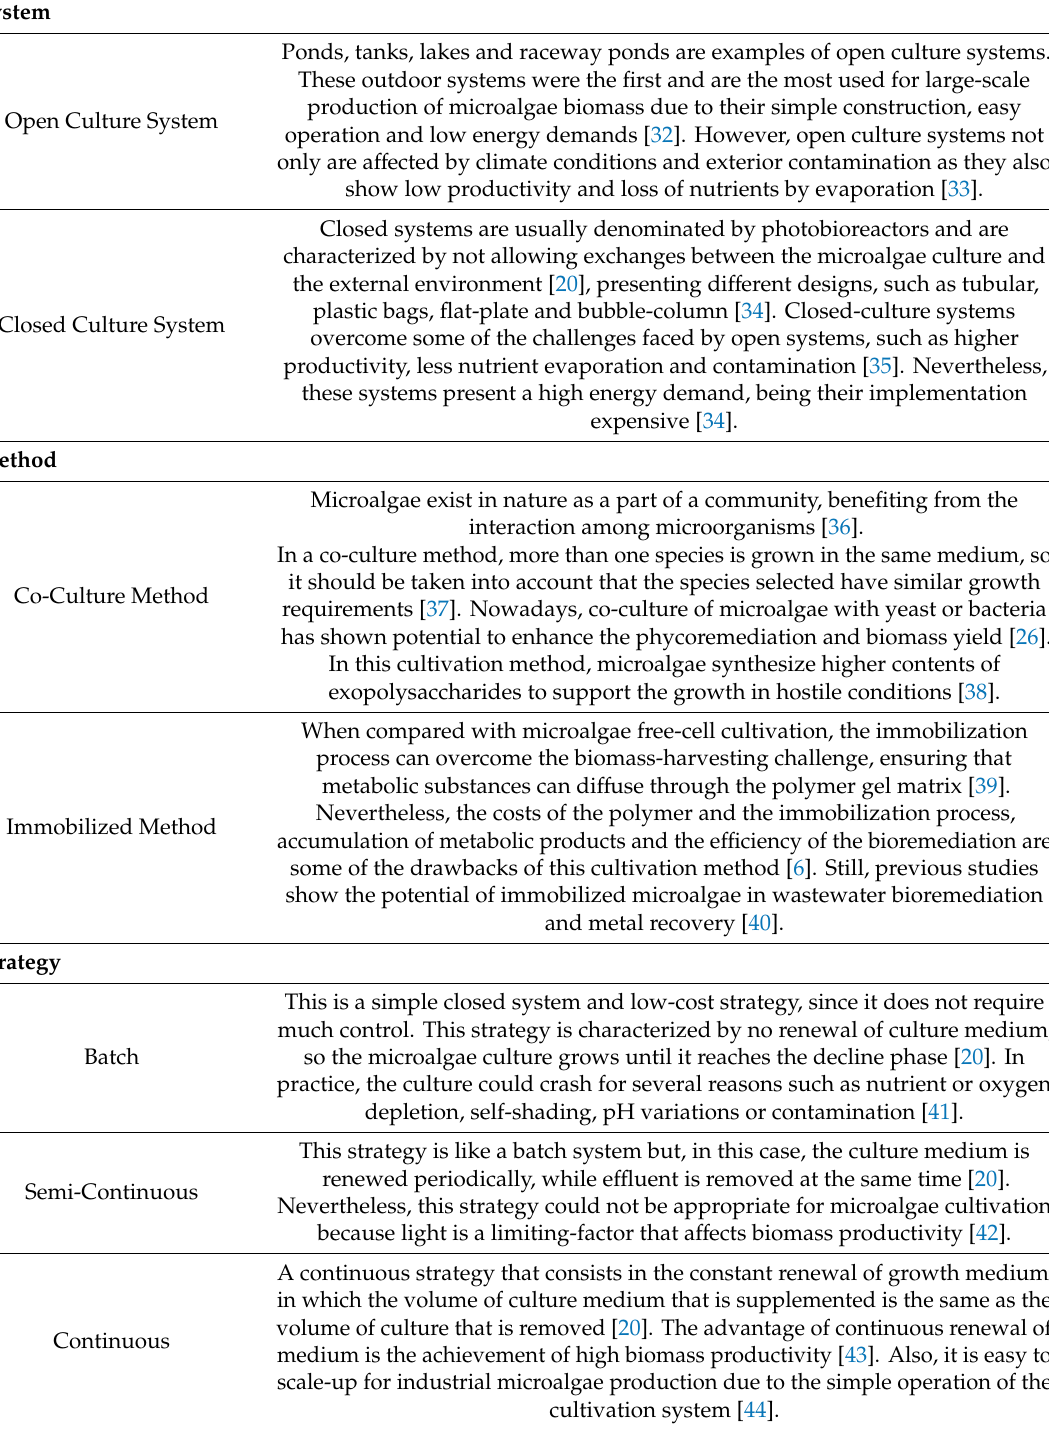
Table 1. Summary of di ff erent systems, methods and strategies of microalgae cultivation commonly used. Microalgae